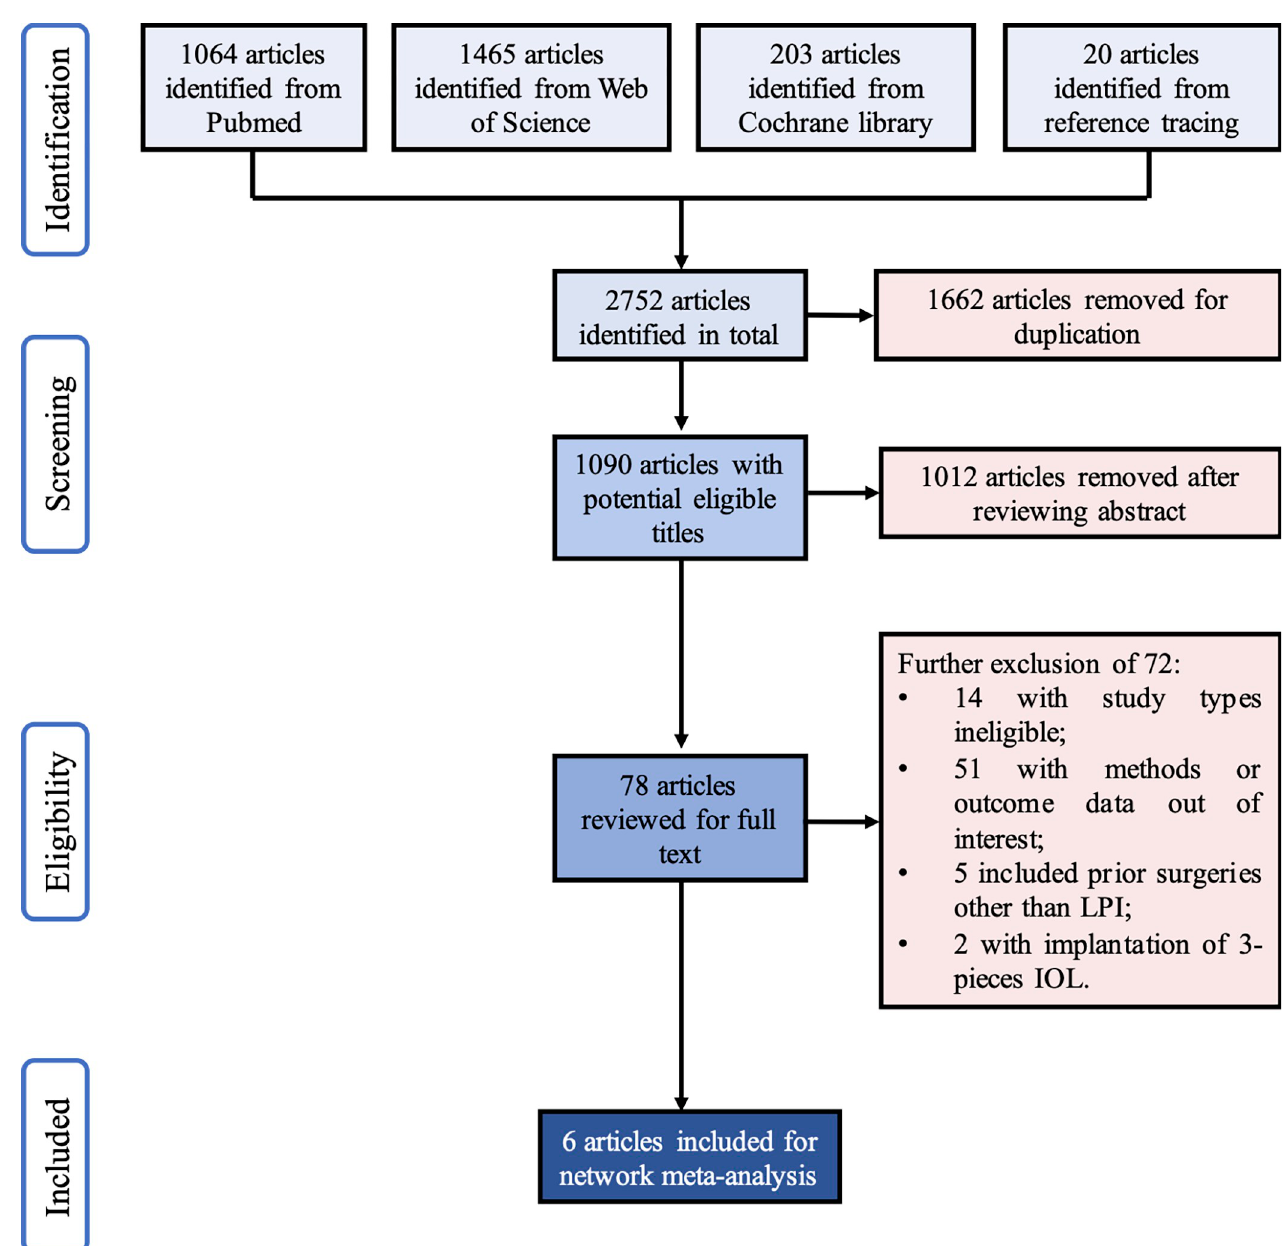
Fig 1. Flowchart of study selection. Shown is the process from database searching to the studies selected for this meta-analysis. After literature search and comprehensive selection, 6 articles were identified eligible for network meta-analysis. LPI: laser peripheral iridotomy; IOL: intraocular